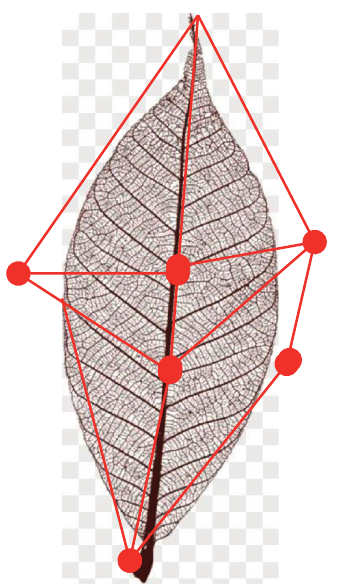
Figure 2: Bezier simulation diagram of the blade.